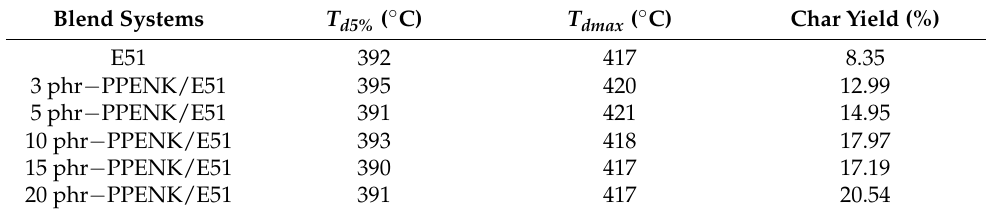
Table 4. Thermal stability date of PPENK/E51 blends. Blend